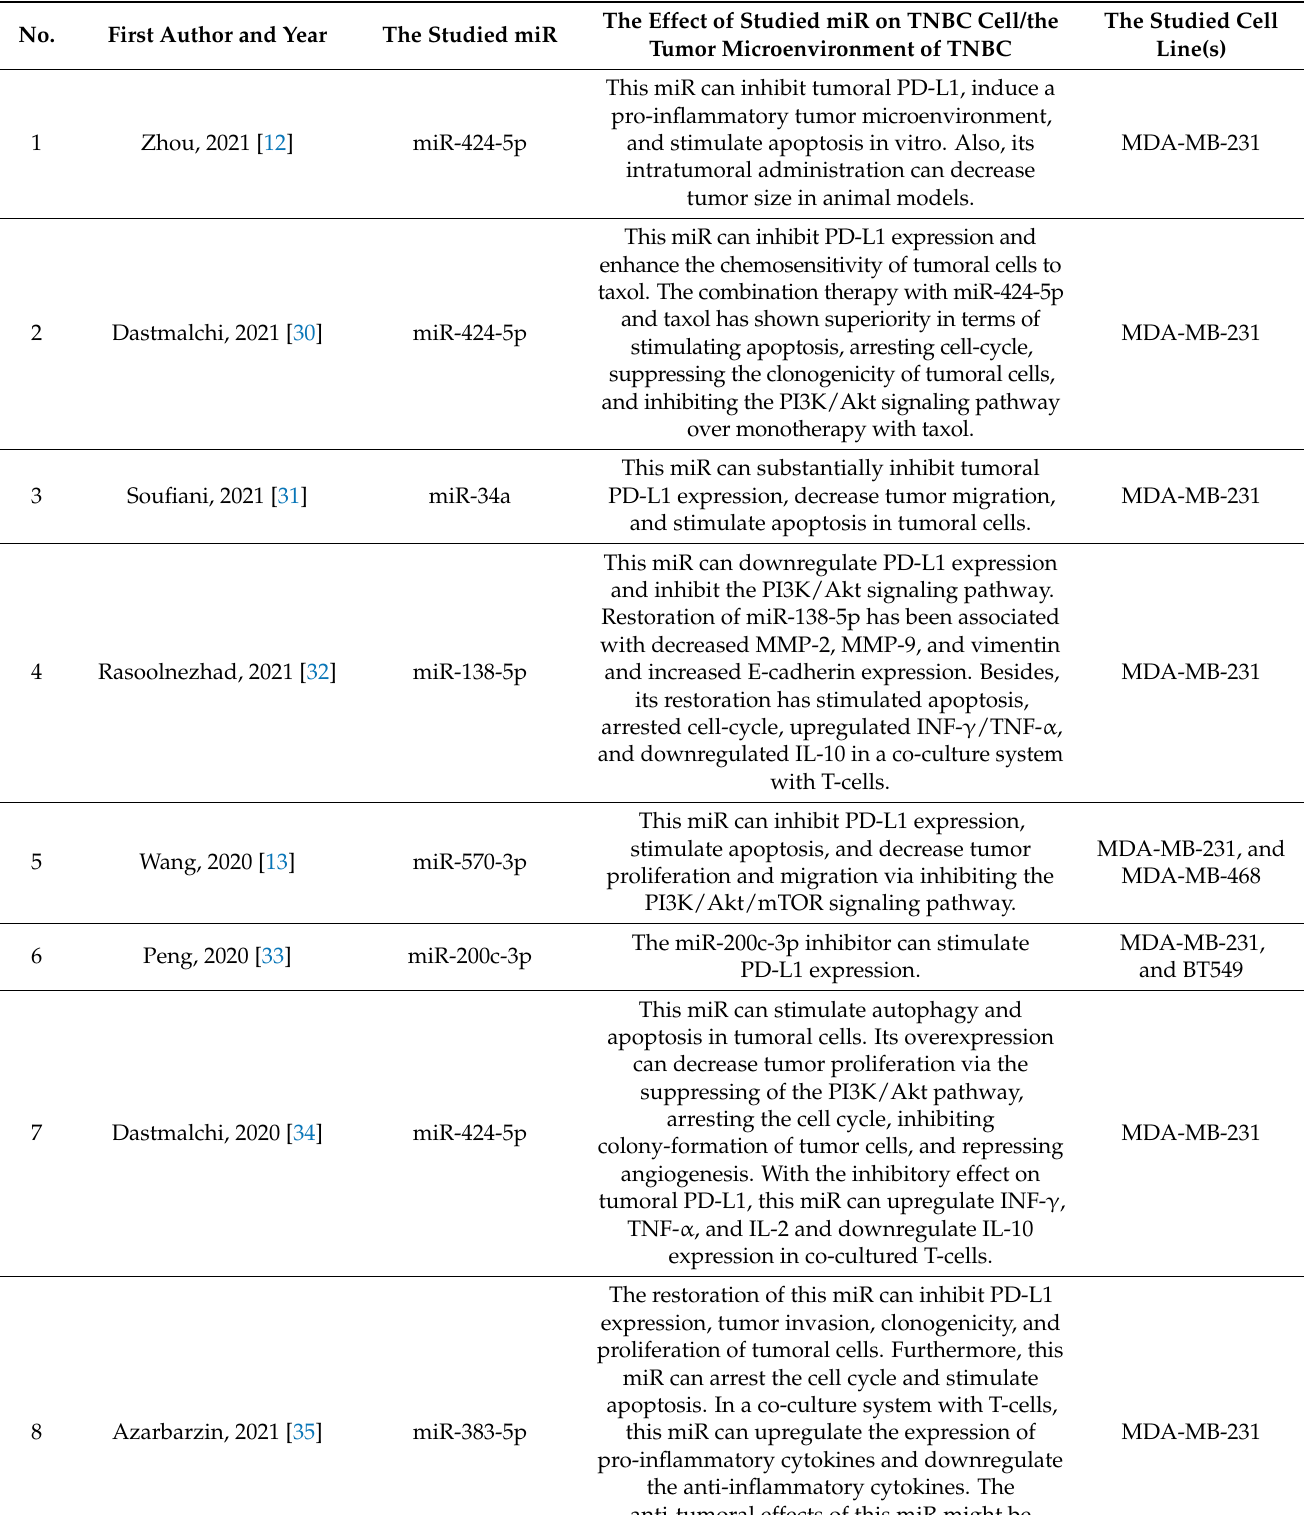
Table 2. The main findings of the included